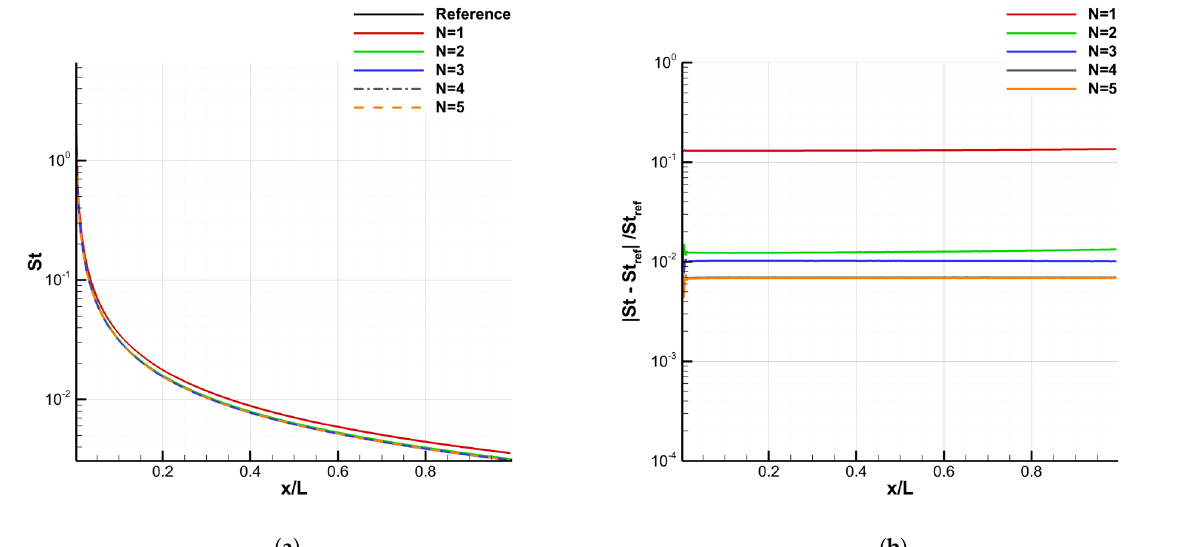
Figure 10. Stanton number for N = 1 to N = 5, and for the reference CLICET solution. ( a ) Stanton number, ( b ) relative error. Test case 1, N x =